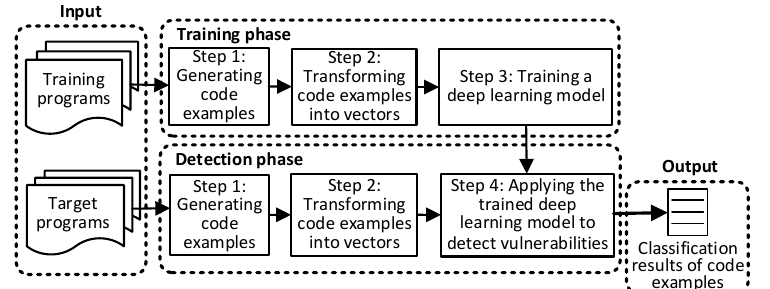
Figure 1. Process of DL-based vulnerability